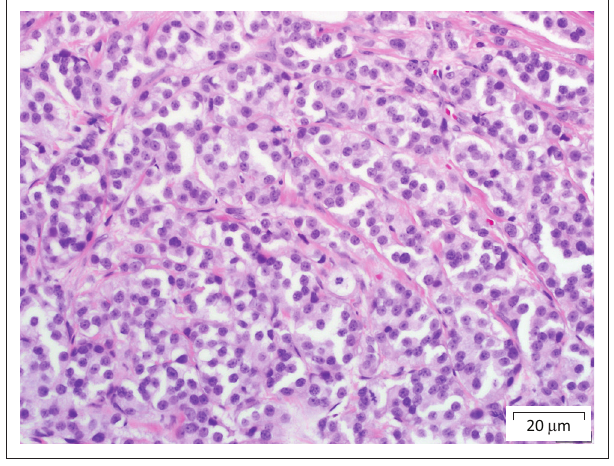
FIGURE 2: Close-up of renal paraganglioma showing neoplastic cells with round to oval nuclei containing one to three nucleoli and vacuolated, pale eosinophilic cytoplasm with indistinct cytoplasmic borders. Packets of neoplastic cells are separated by a thin fibrovascular